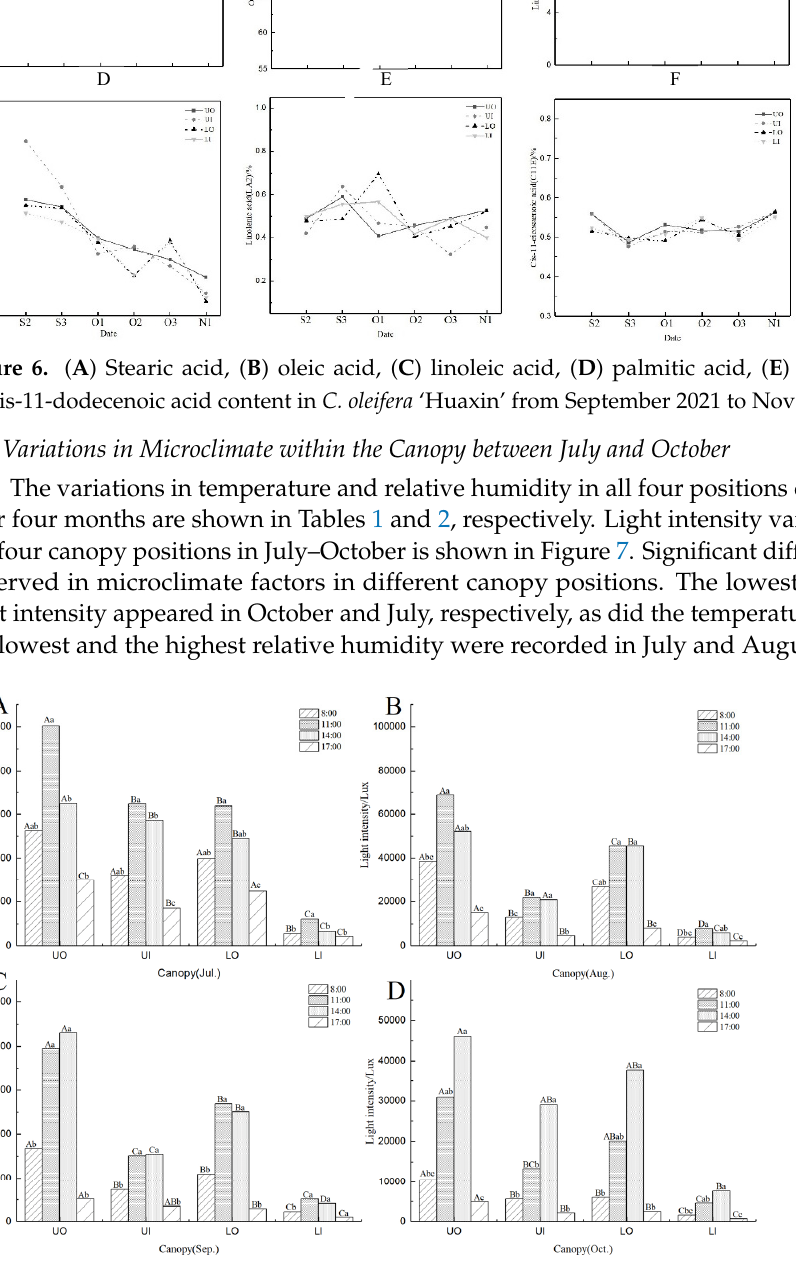
Figure 6. ( A ) Stearic acid, ( B ) oleic acid, ( C ) linoleic acid, ( D ) palmitic acid, ( E ) linolenic acid, ( F ) cis- 11-dodecenoic acid content in C. oleifera ‘Huaxin’ from September 2021 to November 2021.